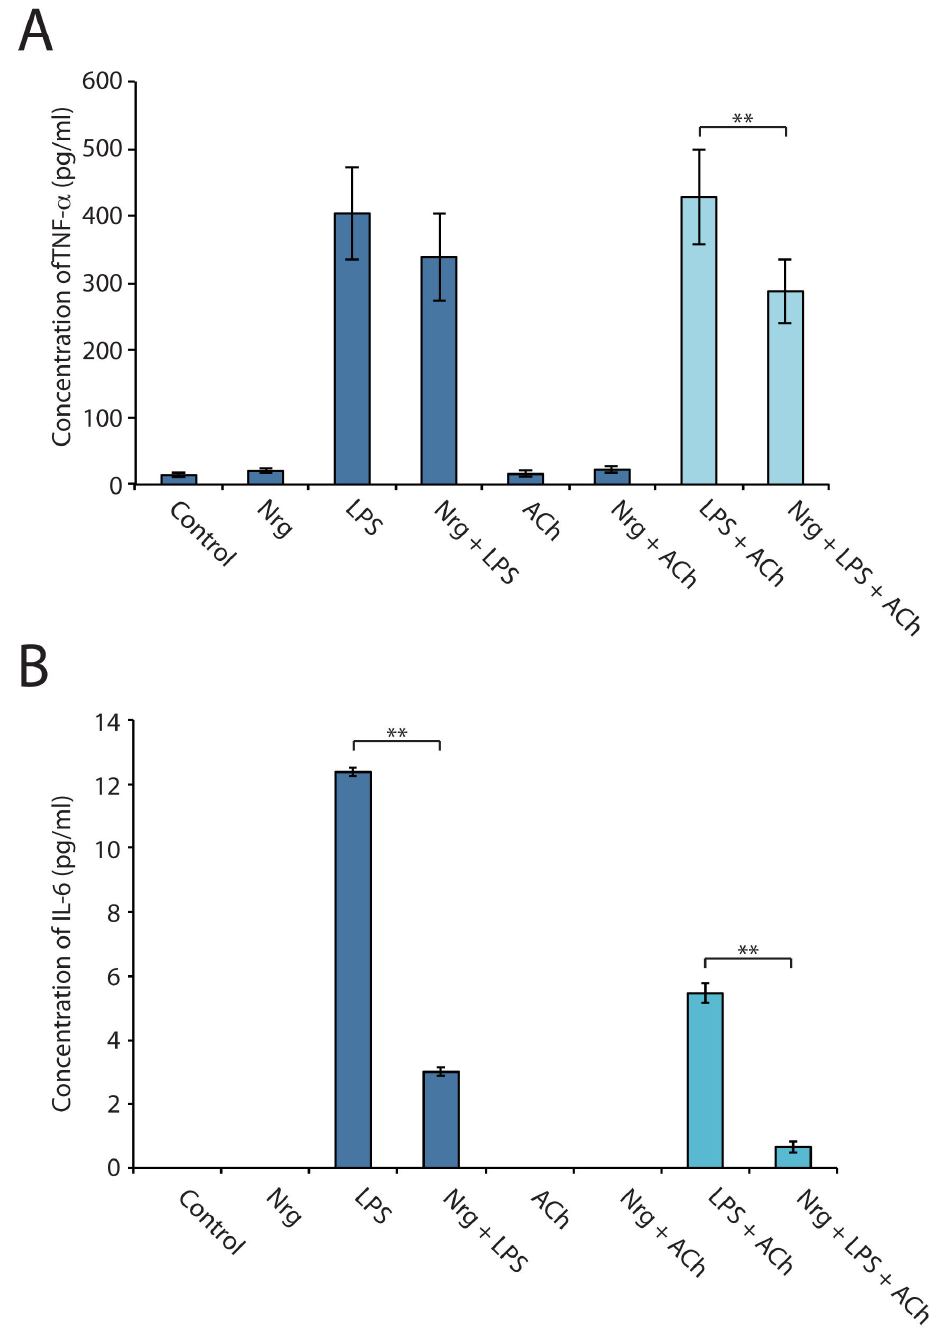
Figure 4. NRG in the presence of ACh induces a significant decrease in secreted TNF-α and IL-6 levels in LPS challenged microglia. Media from untreated (control), NRG, LPS, or both NRG and LPS, in the presence or absence of ACh was analyzed for TNF-α and IL-6 concentrations using a commercially available ELISA kit. BV-2 cells pretreated with ACh and then treated with LPS showed a concentration of 428.02±70.24pg/mL in TNF-α compared to untreated cells while BV-2 cells pretreated with ACh then treated with NRG and LPS showed a concentration of 287.80±47.69pg/mL (n=7, p <0.01, Student’s t-test). Interlukin-6 levels significantly decreased with neuregulin treatment with (0.67±0.17pg/mL, n=3, p <0.0001, ANOVA) or without ACh (3.01±0.12pg/mL, n=3, p <0.05). Taken together our results indicate that BV-2 cells in the presence of ACh and NRG and immunologically challenged with LPS result in a 32.76% decrease in TNF-α and a 87.73% decrease in IL-6 compared to BV-2 cells pretreated with ACh and challenged with LPS alone. doi: 10.1371/journal.pone.0070338.g004 PLOS ONE |